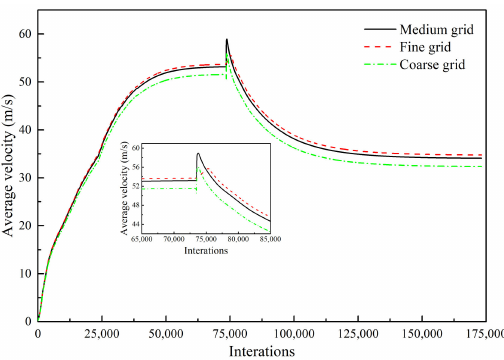
Figure 4. Average velocity of the longitudinal section as a function of three grid resolutions (Scheme 2).